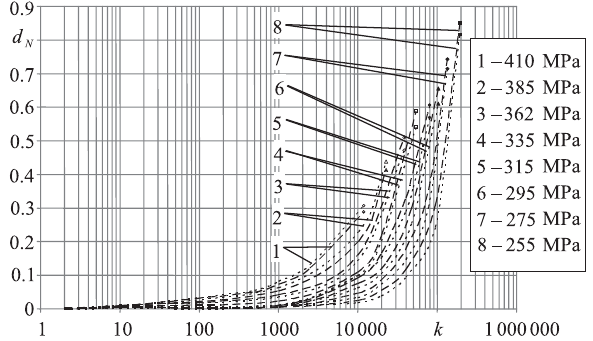
Fig. 11. Fatigue damage variation in pulsating